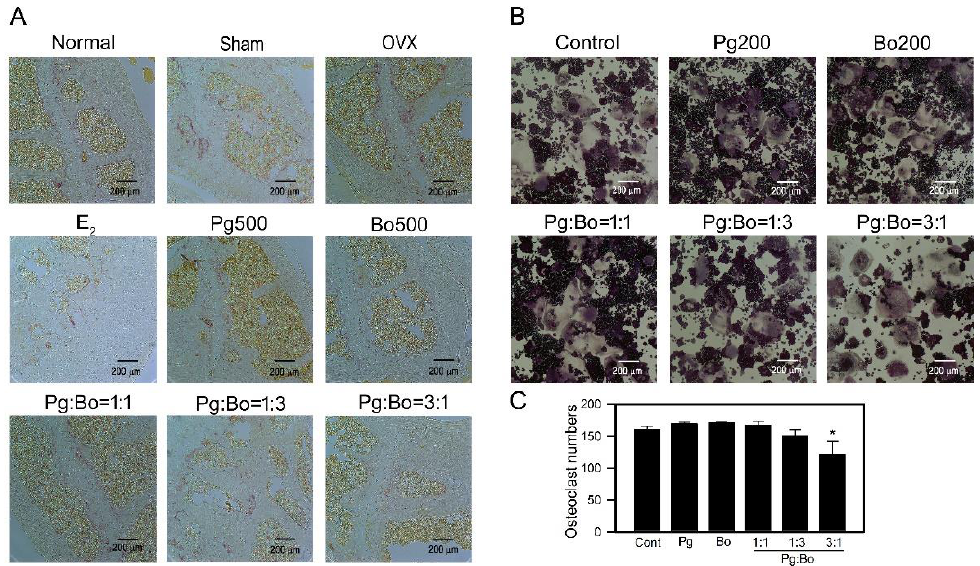
Figure 4. Effect of Pg and Bo on OC formation. ( A ) The femur sections were stained with tartrate-resistant acid phosphatase (TRAP) and histological analysis of each femur was performed under an Axioskop2 Plus microscope at 20× magnification. TRAP-positive cell numbers in selected femur fields were counted ( n = 3). ( B,C ) RAW 264.7 cells were differentiated in the presence of 50 ng/mL receptor activator of nuclear factor kappa B ligand (RANKL) for 4 days and the differentiated OCs were stained with TRAP. TRAP-positive multinucleated OCs were counted ( n = 3). All values are expressed as mean ± SEM, * p < 0.05 compared with control.